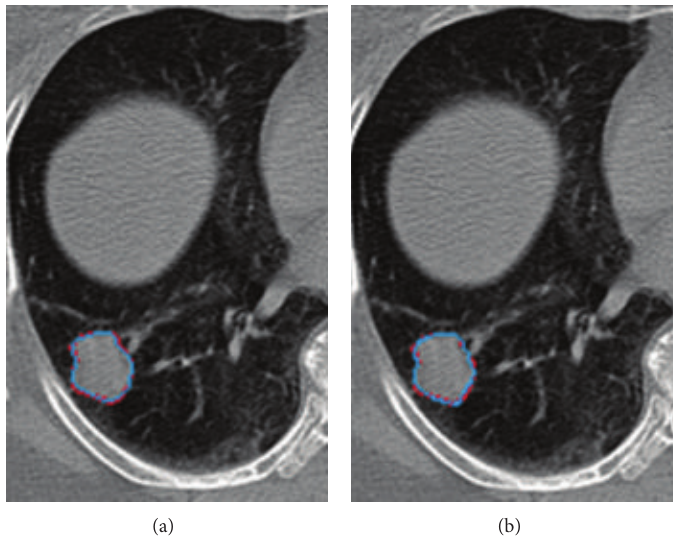
Figure 5: Comparison of automated contouring methods with ground-truth in case 3. (a) Manual contour (red) compared with MPSL (turquoise) based segmentation of GTV. (b) Manual contour (red) compared with DIR based contour (turquoise). Notice that diaphragm with similar intensity as that of the GTV was not included in the contour by the MPSL